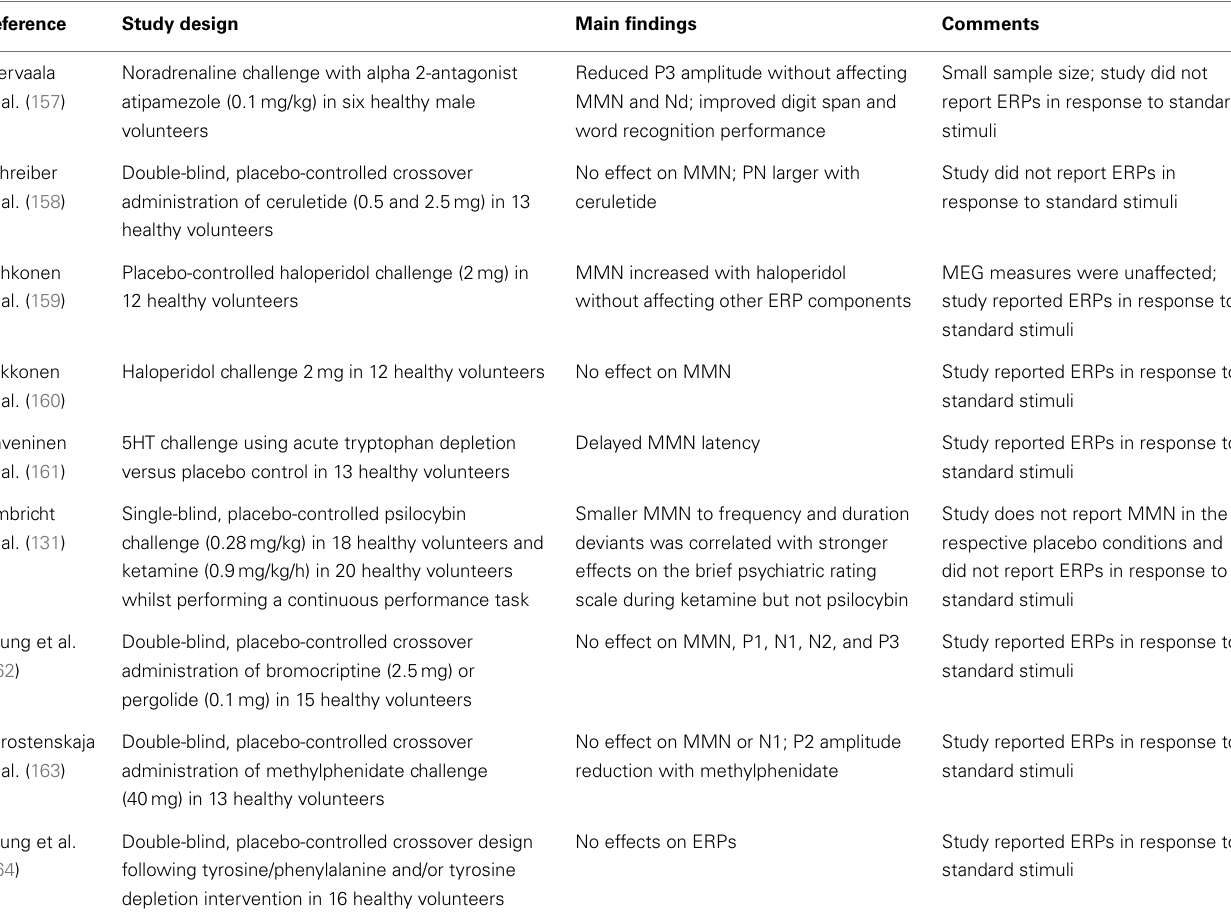
Table 3 | Monoamine receptor